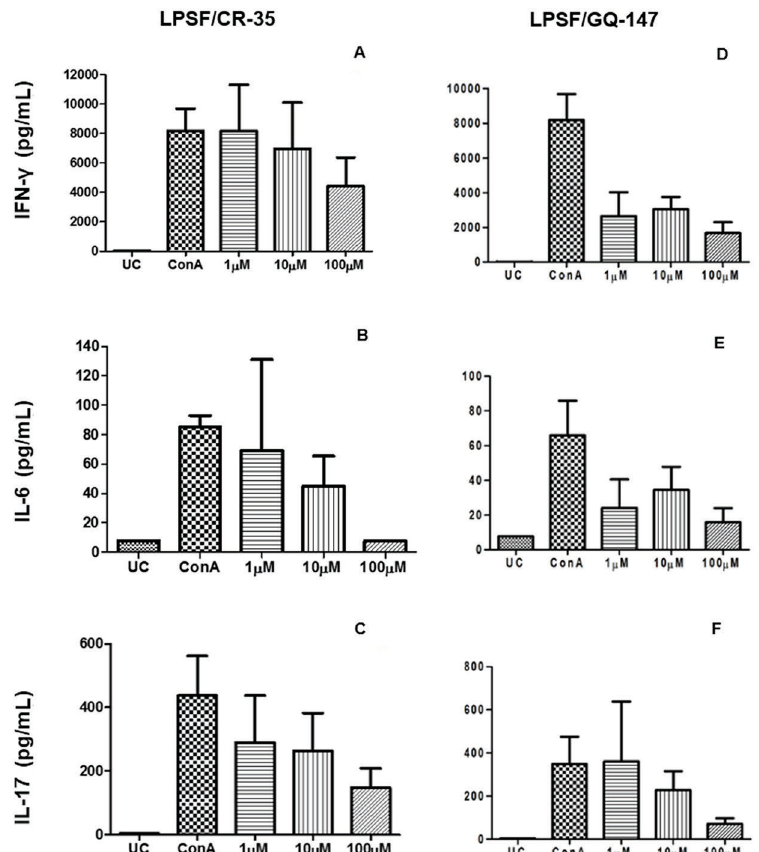
FIGURE 2 - Evaluation of pro-inflammatory cytokines release inhibition by LPSF/CR-35 and LPSF/GQ-147 in BALB/c mice splenocytes culture (n=5). IFNγ (A, B); IL6 (C, D); IL17 (E,F). UC = untreated cells; ConA = concanavalin